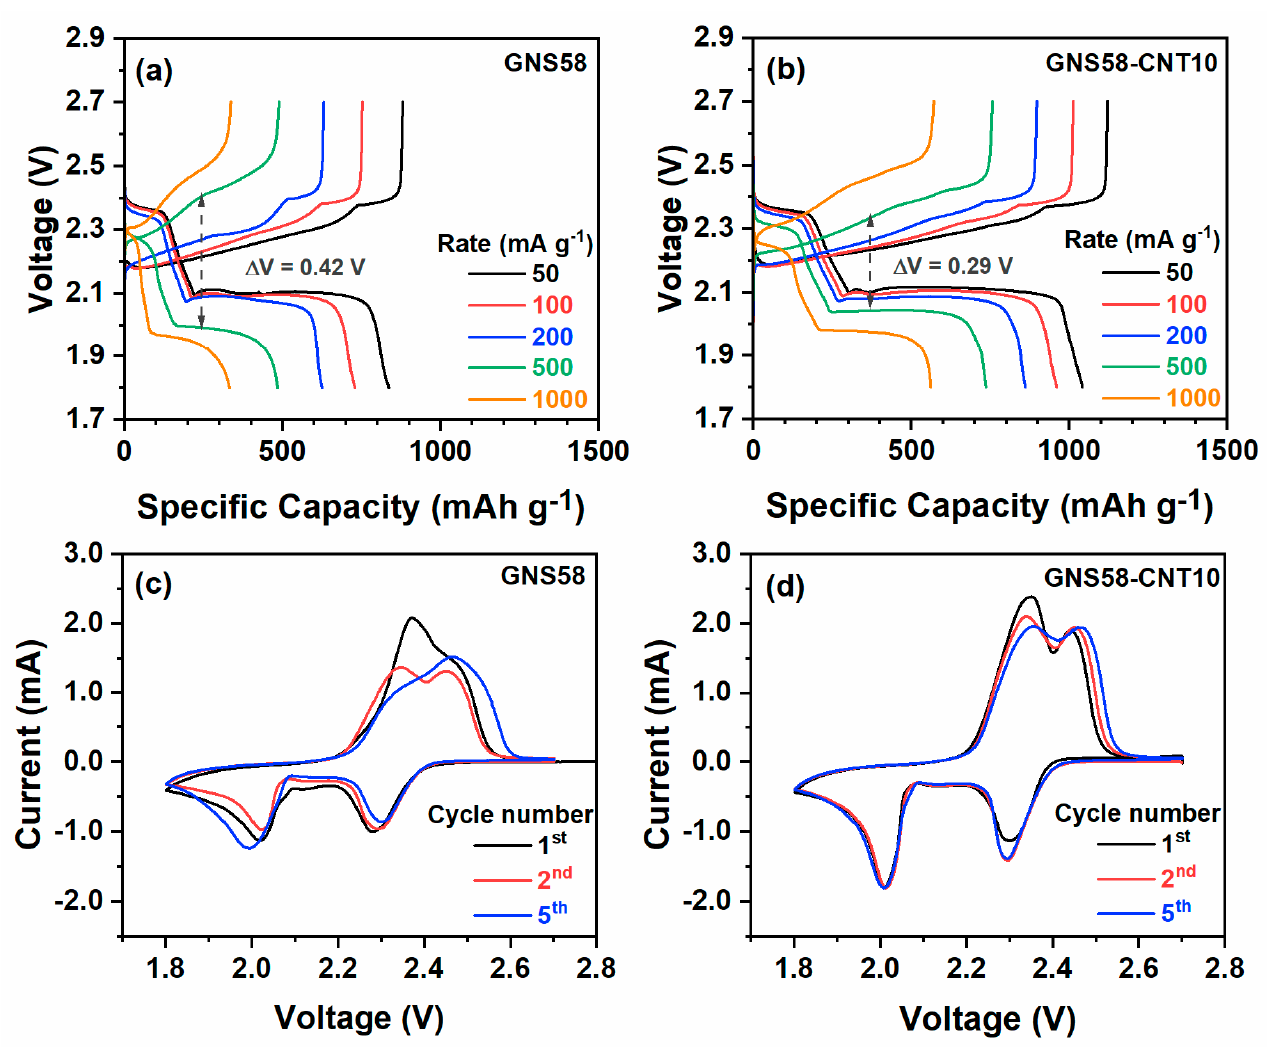
Figure 3. Galvanostatic charge–discharge profiles of ( a ) GNS58 and ( b ) GNS58-CNT10 hybrid cathodes at different current densities. Cyclic voltammograms of ( c ) GNS58 and ( d ) GNS58-CNT10 cathodes at a scan rate of 0.1 mV s − 1 .